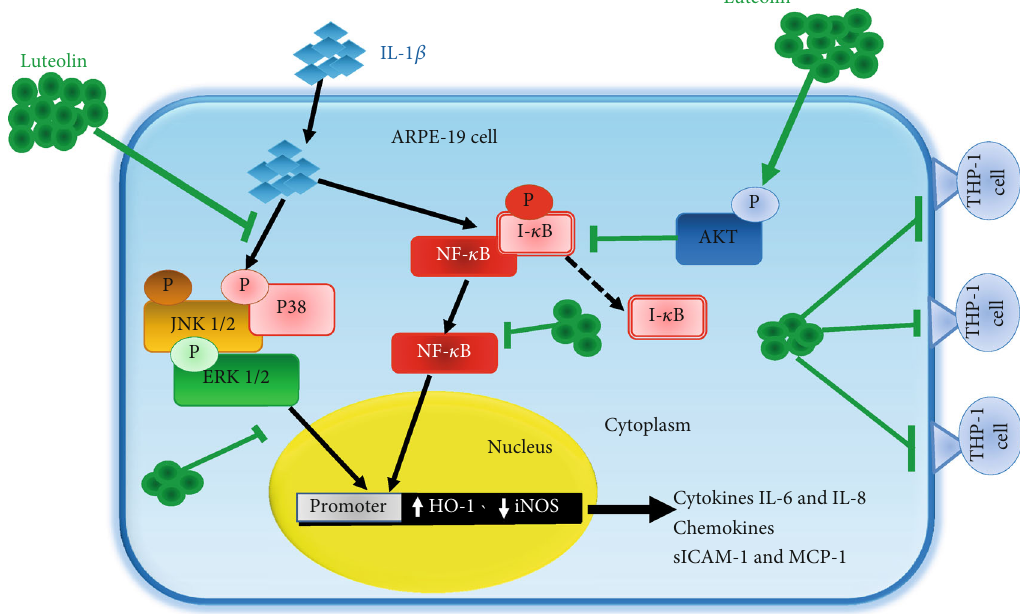
Figure 9: Model explaining the mechanisms via which luteolin inhibits IL-1 β -induced in fl ammation in ARPE-19 cells. Luteolin promotes AKT phosphorylation, thus mediating the NF- κ B and MAPK pathways, leading to decreased release of in fl ammatory-related cytokines, and thereby suppressing THP-1 cell adhesion to IL-1 β -stimulated ARPE-19 cells. Luteolin also increases expression of the anti- in fl ammatory protein HO-1 and inhibits iNOS protein